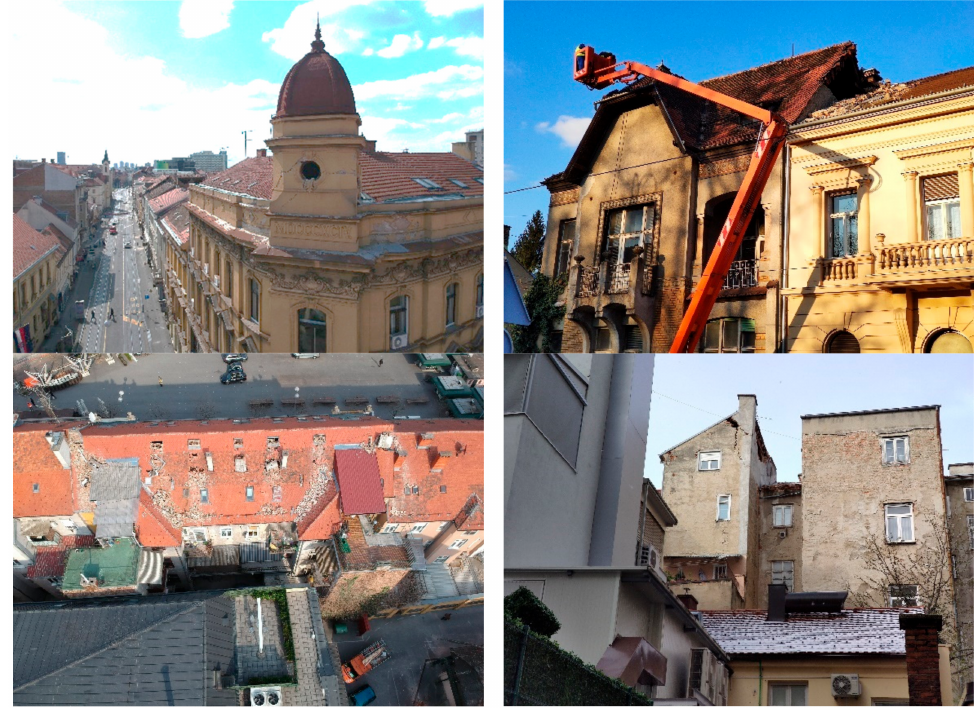
Figure 2. Typical damage of buildings in the city center of Zagreb (photo credit: Mislav Stepinac). The case study building described in this paper is a corner building of a city